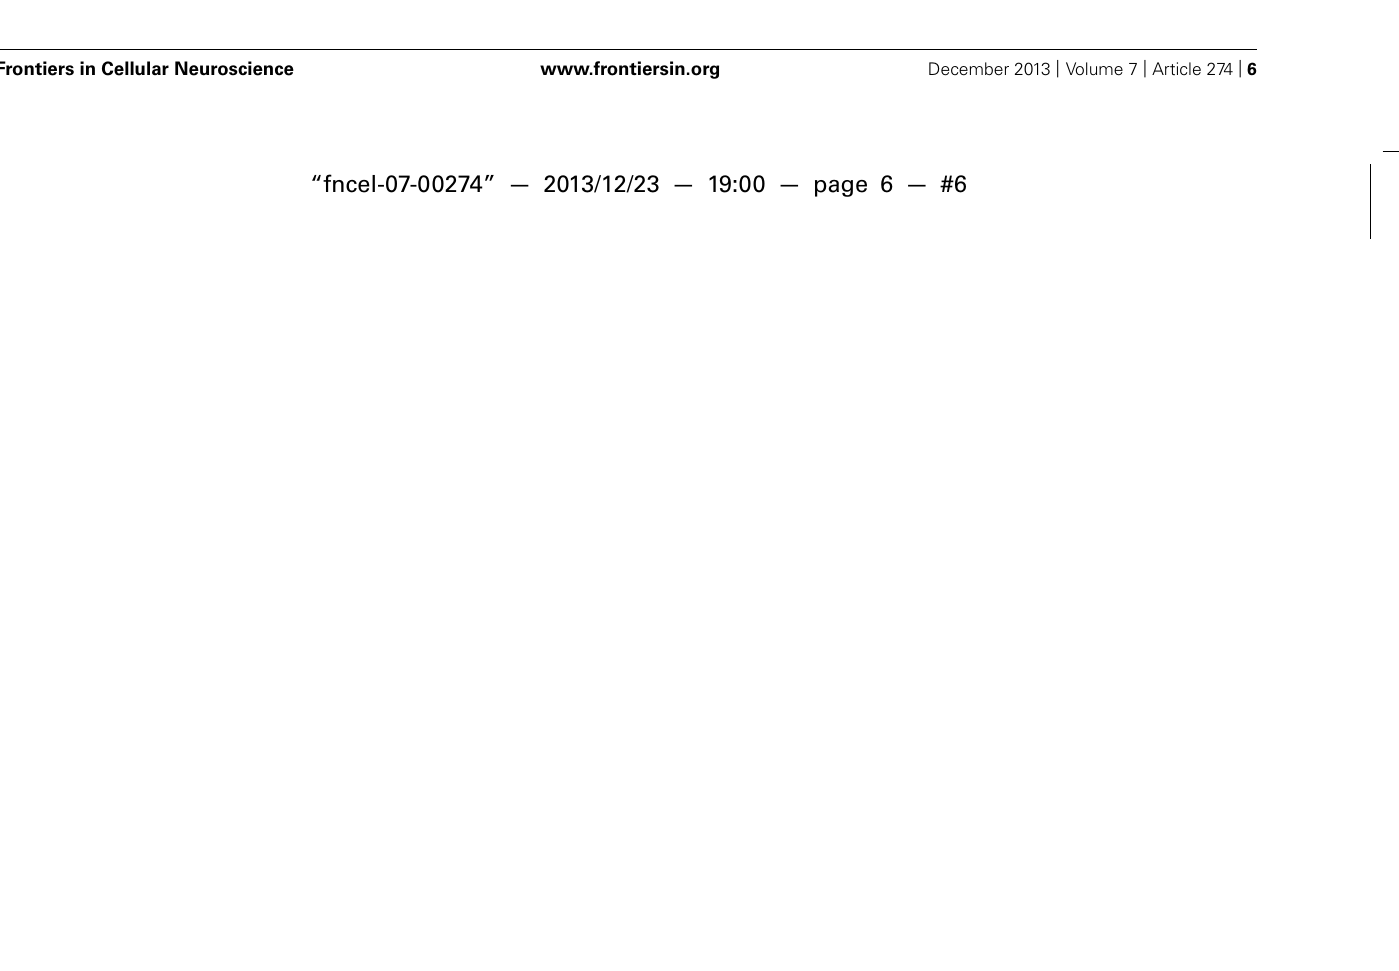
the border between these zones. Scale bar: 50 μ m. (C) Treatment of cultures at DIV15 with foskolin (10 μ M, 3 h) down regulated Iba1 expression and stimulated GFAP expression and growth of processes. Scale bars: 50 μ m. (D) Differential effect of 25 μ M of Leucine-Methyl Ester (Leu-OMe) before and after the phenotypic transition.Treatment with Leu-OMe was applied to cultures at DIV3 and DIV20 to assess the toxicity.Toxicity of Leu-OMe was restricted to the microglia phenotype.This experiment was repeated with three independent isolations of AbA cells. Scale bars: 20 μ